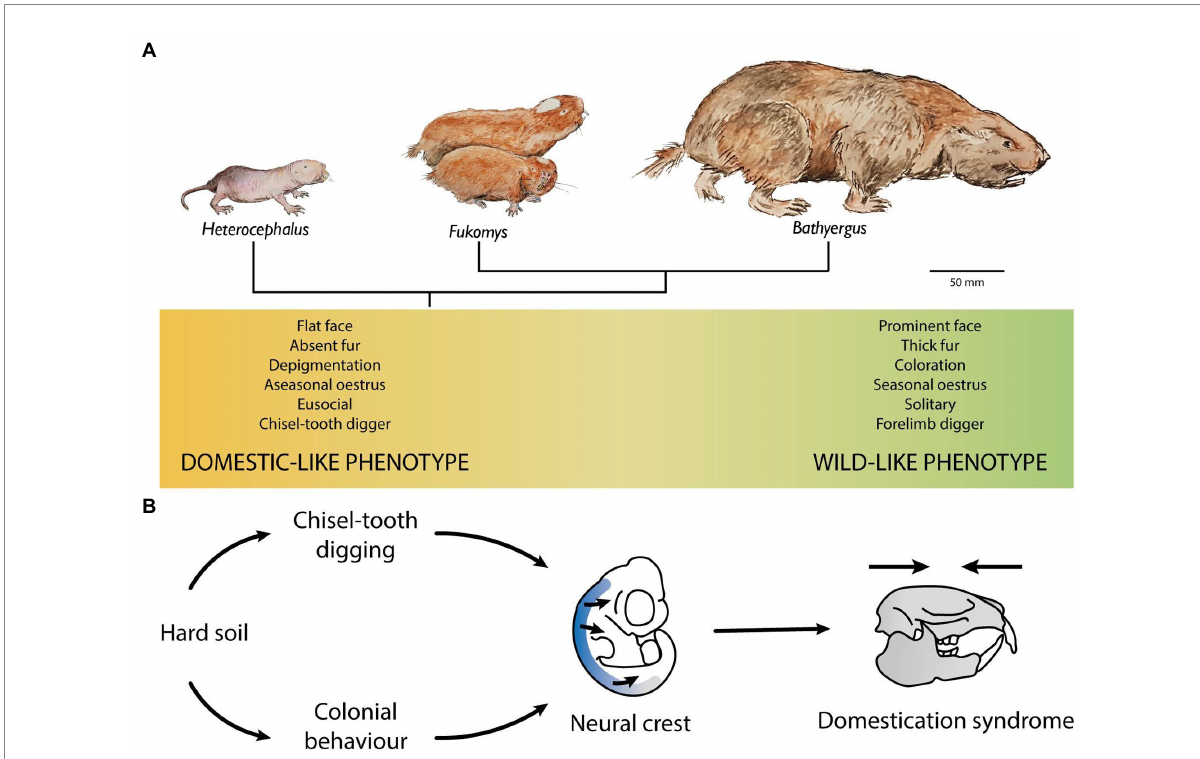
FIGURE 4 Domestication syndrome in subterranean rodents. (A) Evolution of the African mole-rats from a domestic to a wild morph. (B) The subterranean niche could promote self-domestication. Chisel-tooth digging facilitates breaking hard ground, and a colonial, cooperative lifestyle reduces the amount of work carried out of each individual. Therefore, coloniality and chisel-tooth digging could be adaptations to hard soils. Coloniality needs a high degree of social tolerance, and chisel-tooth digging needs flat faces for large muscle attachments, which could serve as selective pressures foe the neural crest producing the appearance of the domestication syndrome in subterranean rodents. Furthermore, large number of individuals underground generate a hypoxic environment which could favour the appearance of defects in the neural crest